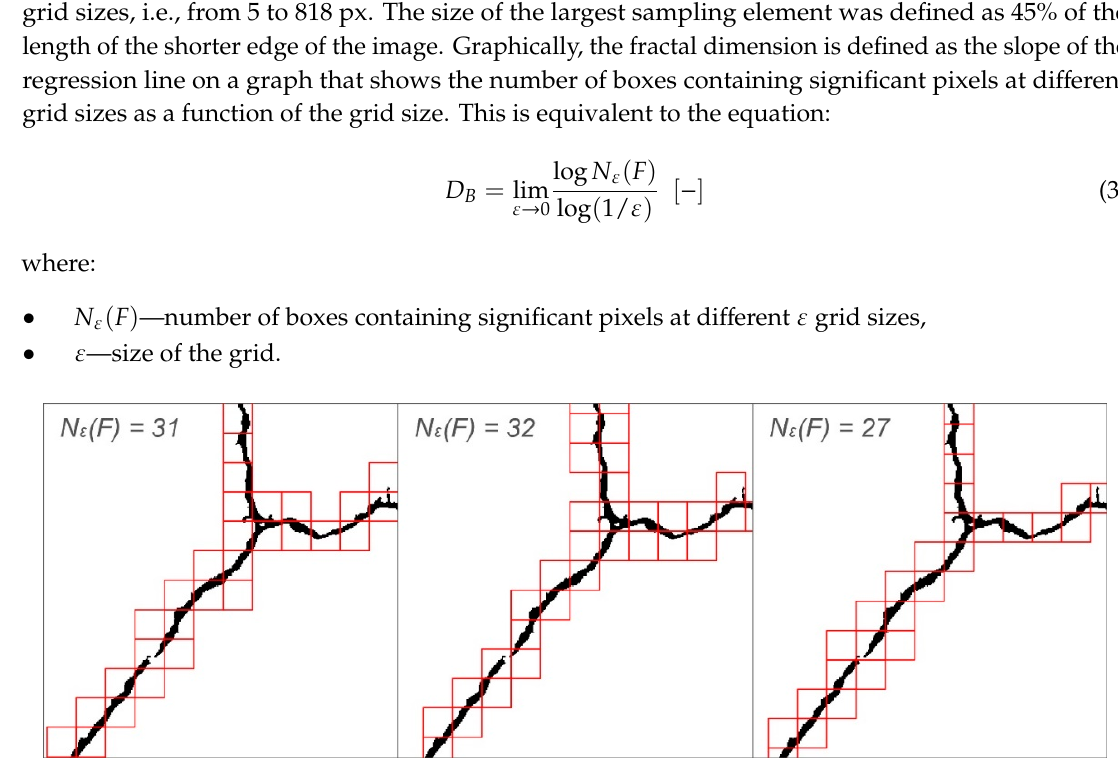
Table 1. Mechanical properties of the lime cement matrix, both for reference samples and those subjected to the thermal load.